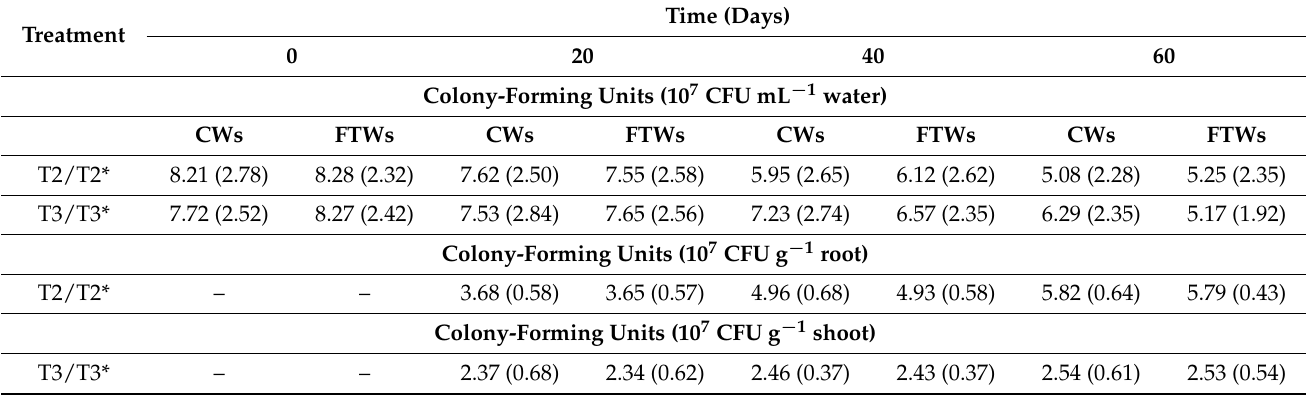
Table 2. Presence of the bacterial strains in the water, roots, and shoots of Phragmites australis vegetated in CWs and